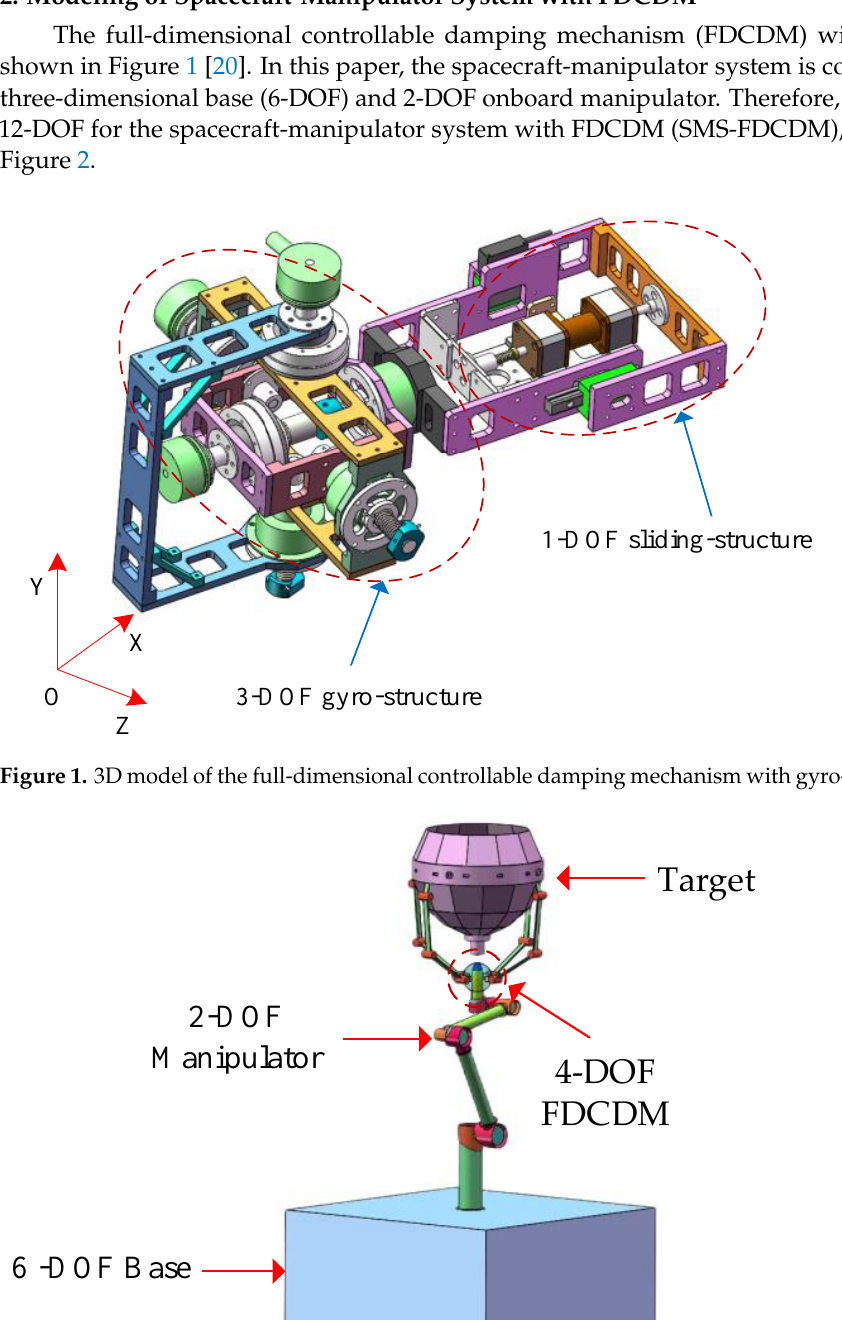
Figure 2. The spacecraft-manipulator system with FDCDM (SMS-FDCDM).